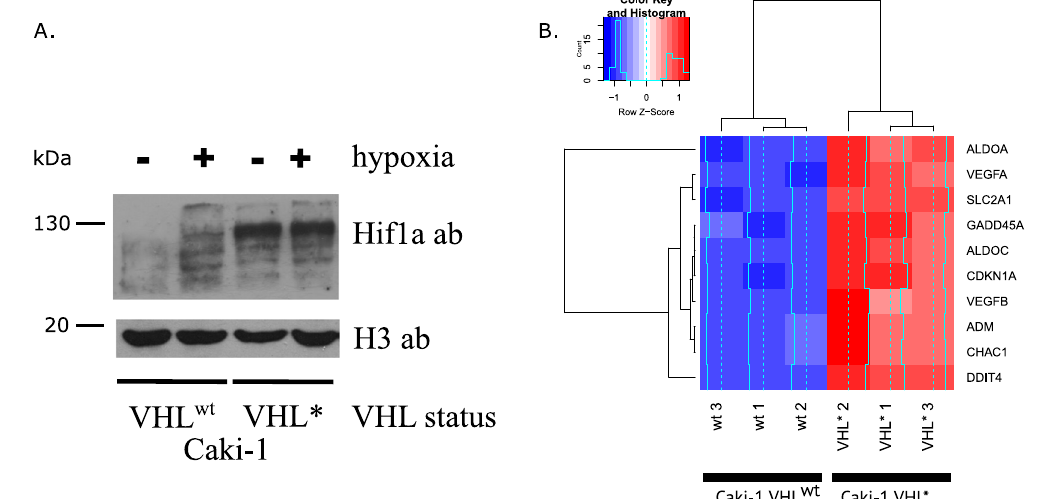
Figure 1. ( A ) Western blot depicting the levels of Hif1a and H3 (control) proteins depending on VHL mutation status and the presence of hypoxia. ( B ) Heatmap showing the changes in expression of the hypoxia-associated genes. Hypoxia-inducible genes were activated in Caki-1 VHL *